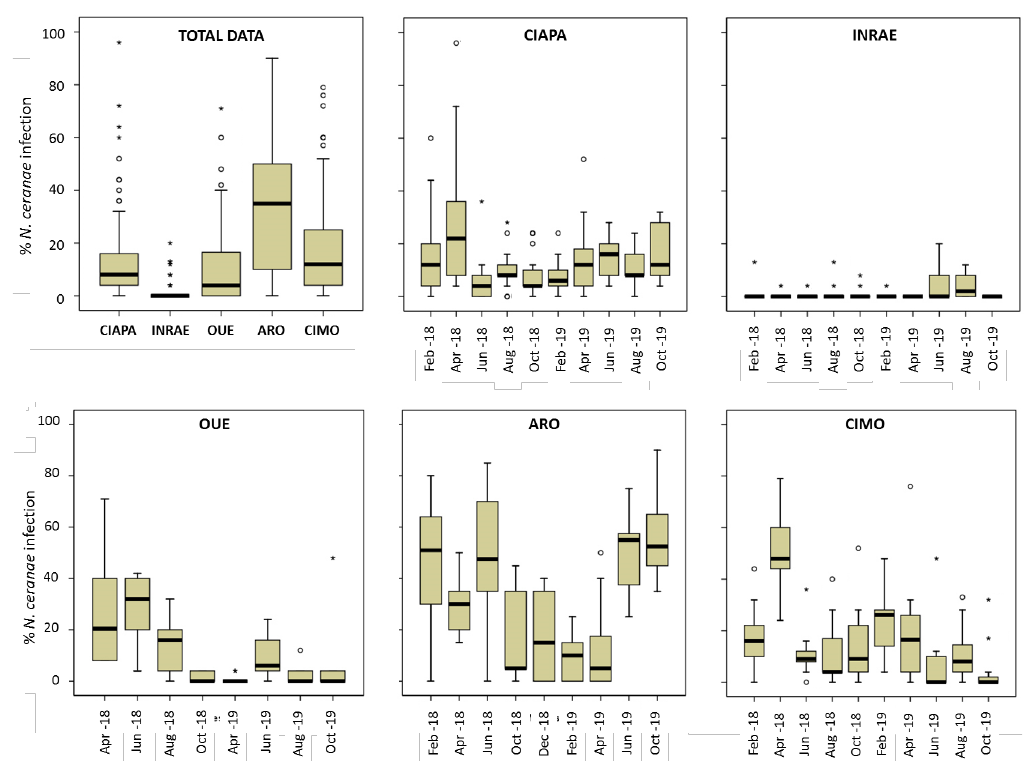
Figure 2. N. ceranae intra-colony level of infection. Total data per apiary and data per each apiary and